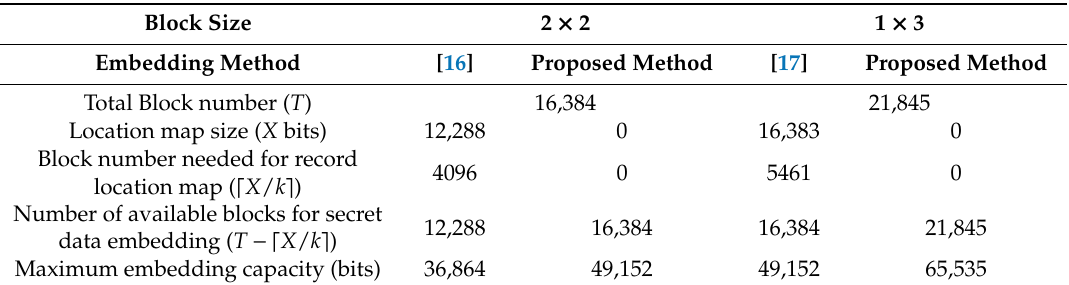
Table 2. The comparisons of embedding capacities among Imaizumi et al.’s [16], Aryal et al.’s [17], and the proposed methods for image size 256 × 256 and k = 3. Block